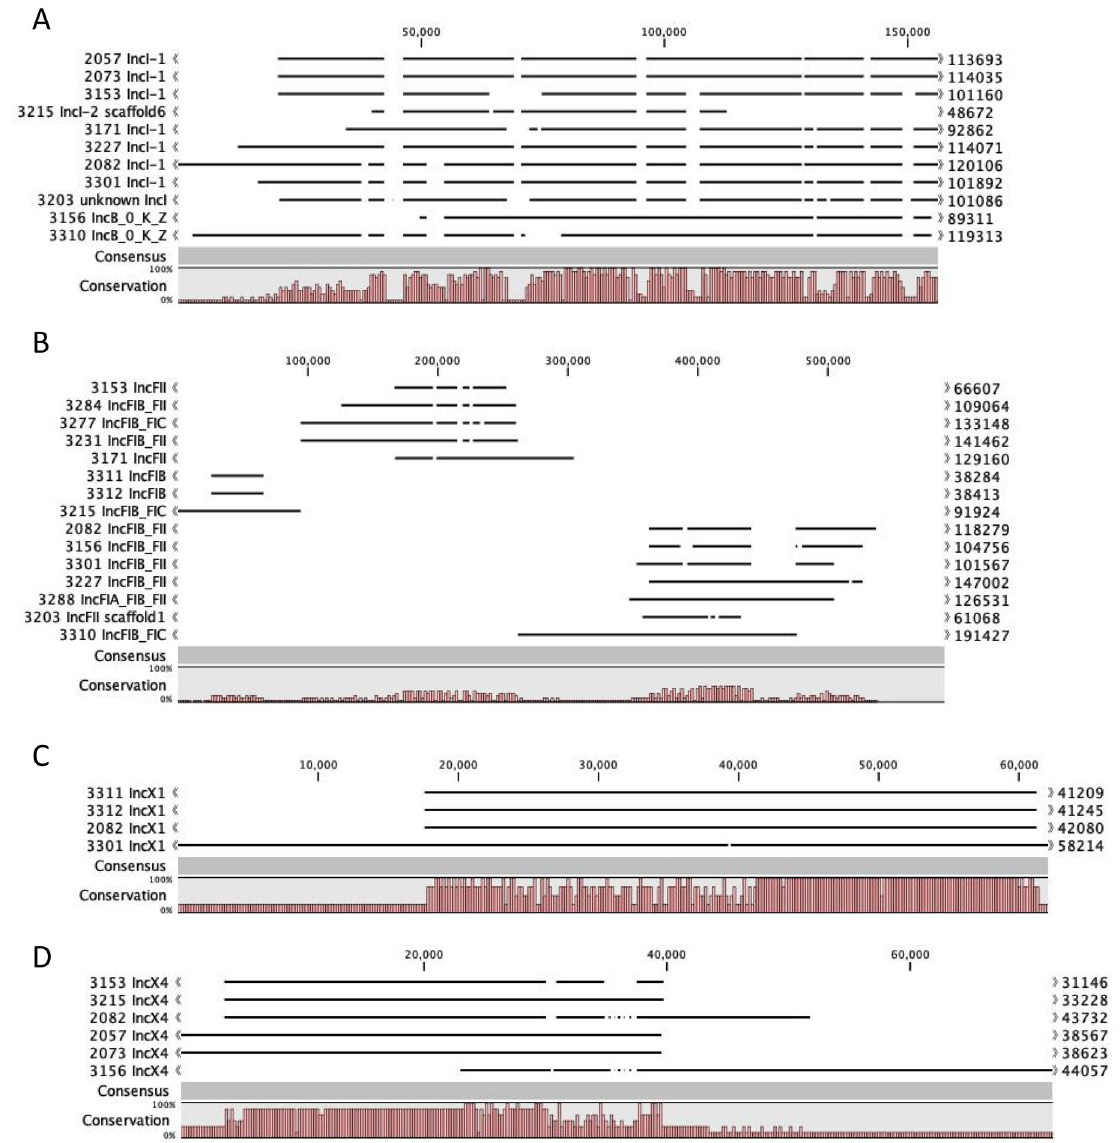
Figure 3. alignments showing the similarity between the same plasmid types: IncI-like ( A ), IncF-like ( B ), IncX1-like ( C ) and IncX4-like ( D ), within different E. coli strains. Imperfect assemblies are distinguished by scaffold in the